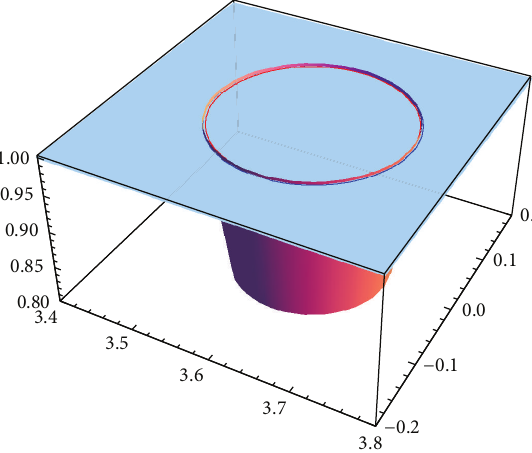
Figure 10: Corona delimited by the circles (𝐶 3 , 𝐶 4 ) .